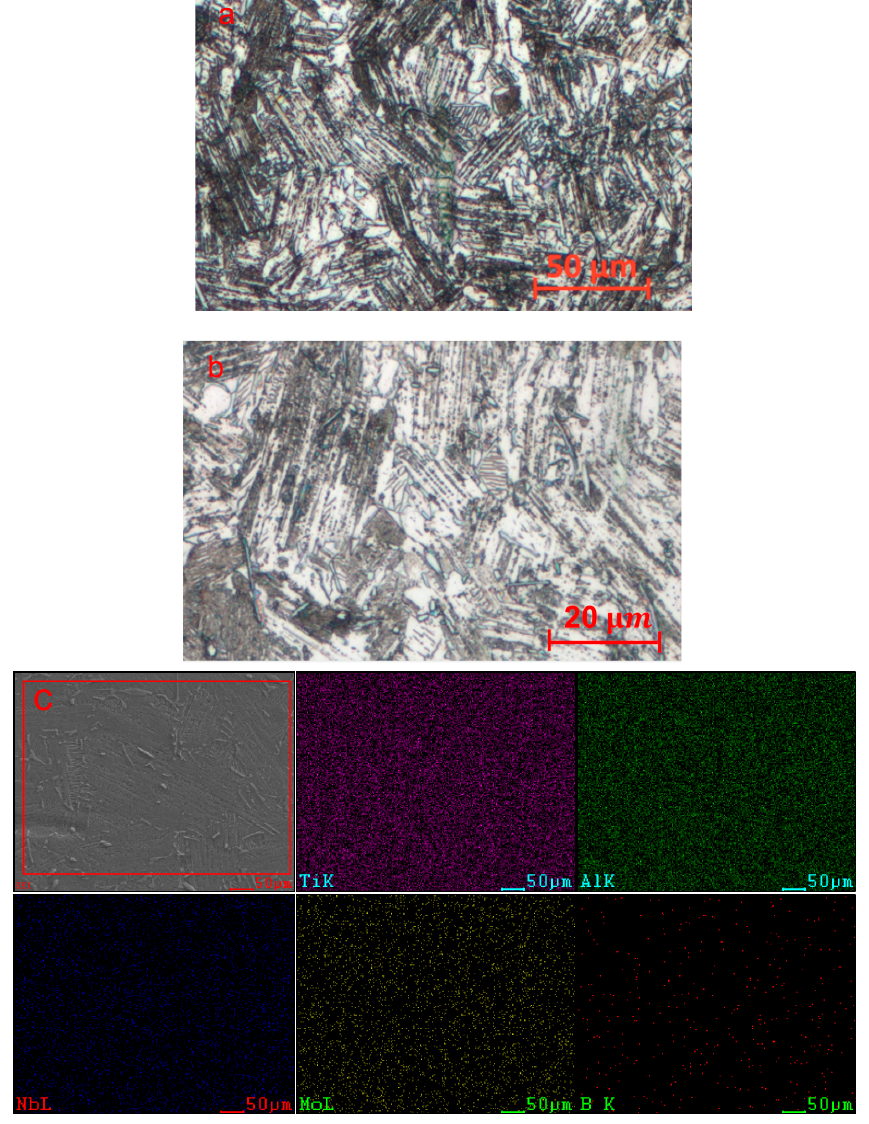
Figure 1. OM ( a ) and magnified OM ( b ) images of microstructure and ( c ) Energy dispersive spectrum under scanning electron microscope of received TiAl alloy.